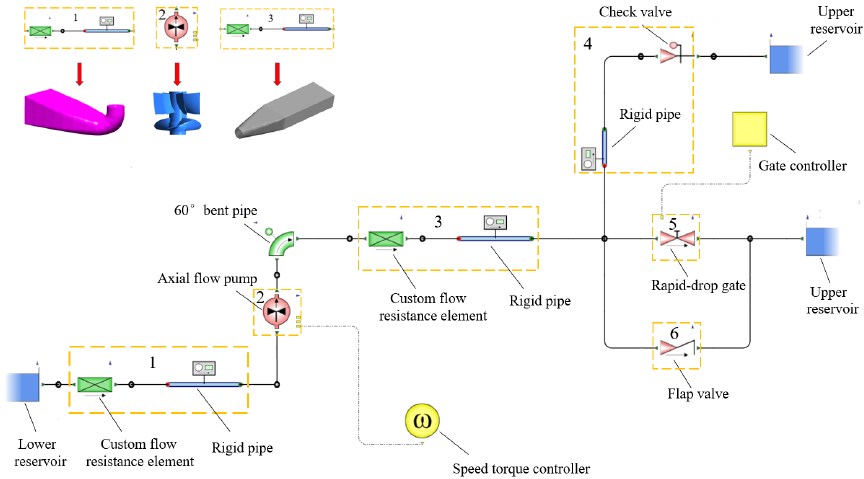
Figure 6. Schematic diagram of the LAPS simulation model.